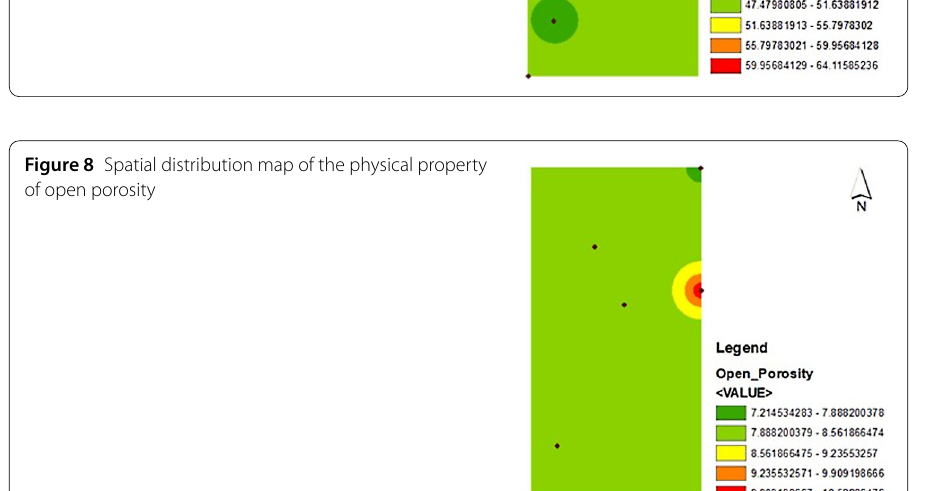
Figure 8 Spatial distribution map of the physical property of open